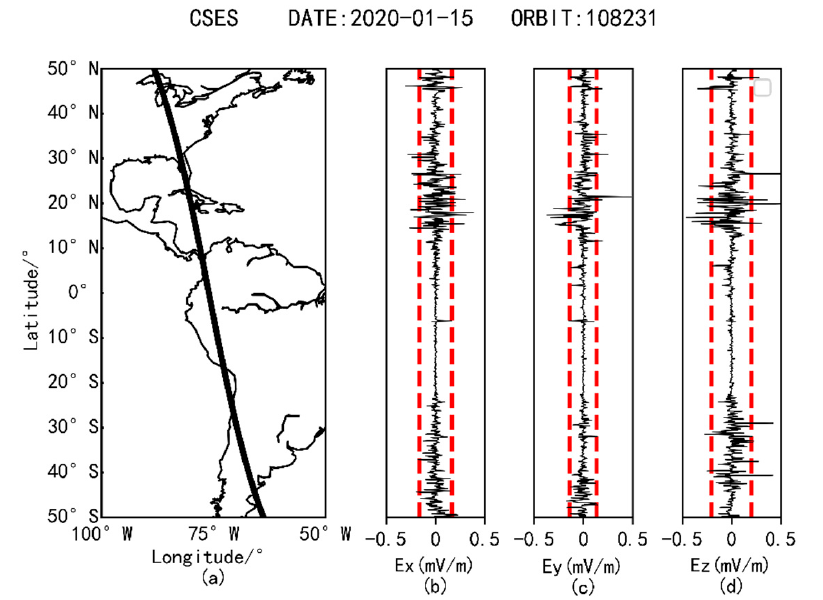
Figure 7. The 108,231 orbital position and disturbance waveform (In subfigure ( a ), the black star is the epicenter position and the black curve is the satellite flight path. Subfigure ( b – d ) depicts the small ‐ scale residual disturbance waveforms after removing the electric field trend from the three components of the electric field ULF band.).